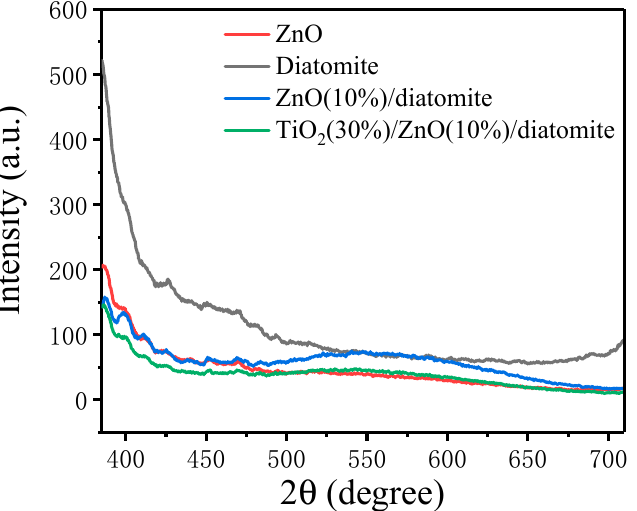
Figure 6. PL spectra of diatomite, ZnO, ZnO(10%)/diatomite, and TiO 2